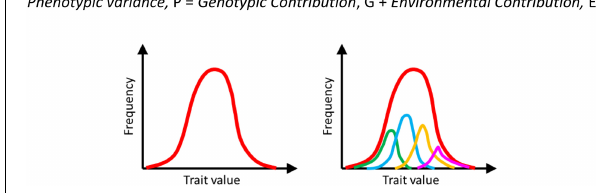
FIGURE 1 | Heterogeneity in a population is a result of both genetic and environmental contributions. The overall manifestation of this heterogeneity in a population is a distribution of the phenotype on the left (red curve). This heterogeneity comprises heterogeneity due to different genotypes (indicated by green, blue, orange, and pink on the right) and the environmental noise (variation within each genotype). For example, the phenotypic distribution represented by the blue curve represents the trait distribution among isogenic individuals. This variation is because of environmental